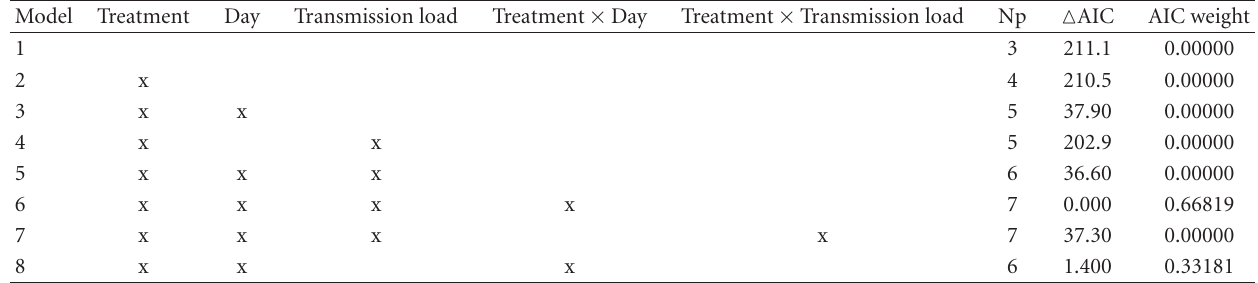
Table 10: Results from model selection on space use (proportion use of lower half of enclosure) among domestic wild animals using the AIC criterion (Np is number of